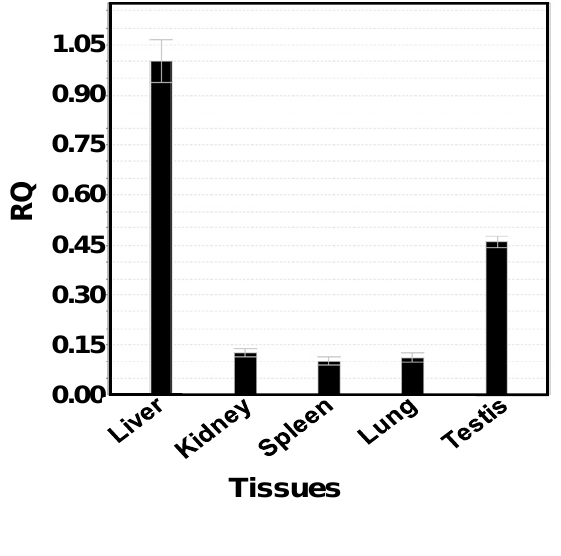
Figure 12. Expression of SOD1 using Real time PCR and cDNA from different camel tissues. The results are expressed relative to liver as calibrator and using 18S ribosomal subunit as housekeeping